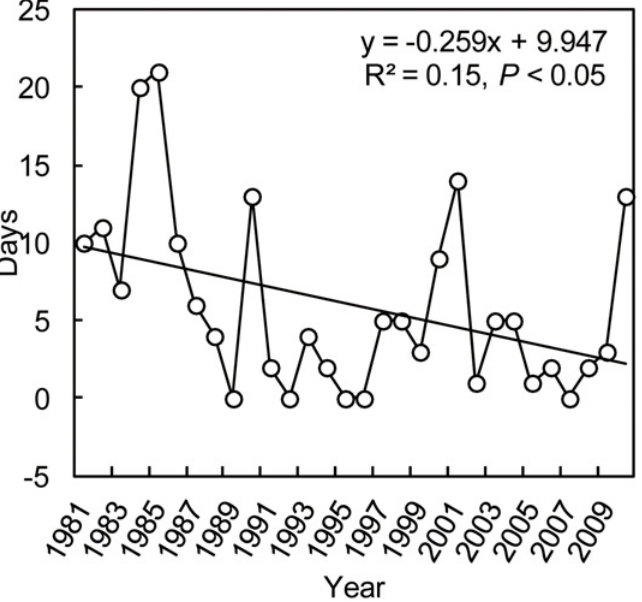
Fig 5. Yearly variations in days for extreme heating (a) and cooling (b) energy consumption of residential